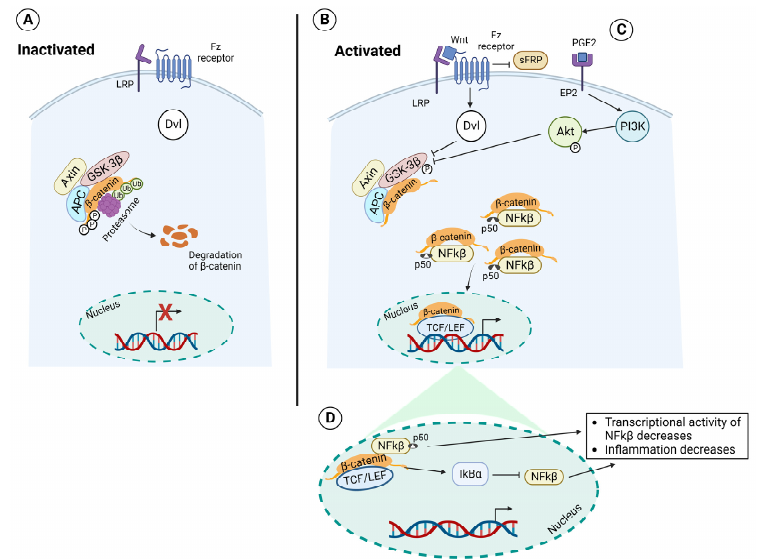
Figure 3. PGE2 Promotes Immunoregulation through Cross-Regulation between β -catenin and NF- κ B by Activating the Wnt- β -catenin Signaling Pathways. ( A ) Without the Wnt ligand, β -catenin is bound by GSK-3 β , Axin, and APC. This binding-stimulated phosphorylation of β -catenin by GSK-3